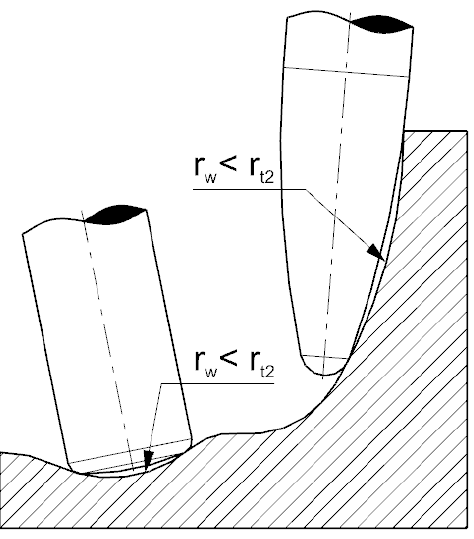
Figure 2. Example of circle segment end mills